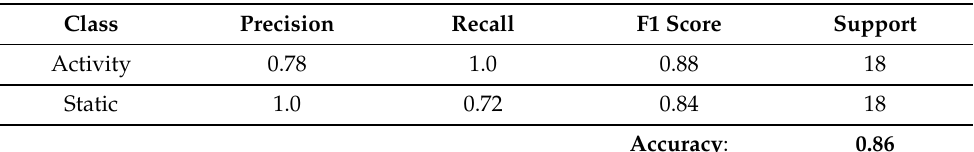
Table 1. Classification performance for batch processing motion detection for the selected dataset and fixed threshold at 5 ×